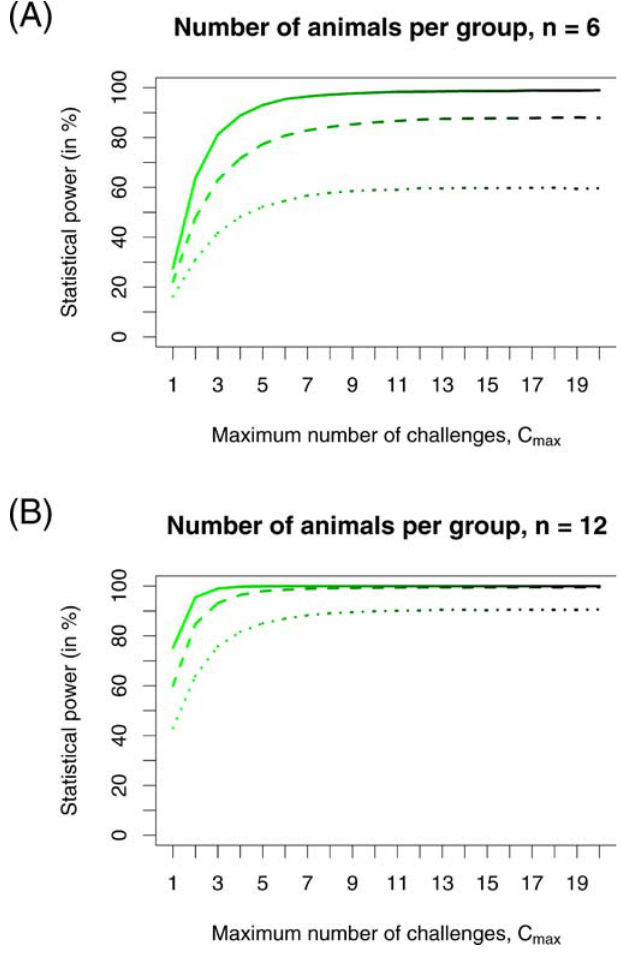
Figure 3. Impact of the Maximum Number of Challenges, C max , on the Statistical Power For this plot we assumed trials with vaccine efficacies of VE S ¼ 0.67 (dotted line), VE S ¼ 0.8 (dashed line), and VE S ¼ 0.9 (solid line). In (A) we calculated the statistical power for six animals per group, n ¼ 6, and in (B) for 12 animals per group, n ¼ 12. DOI: